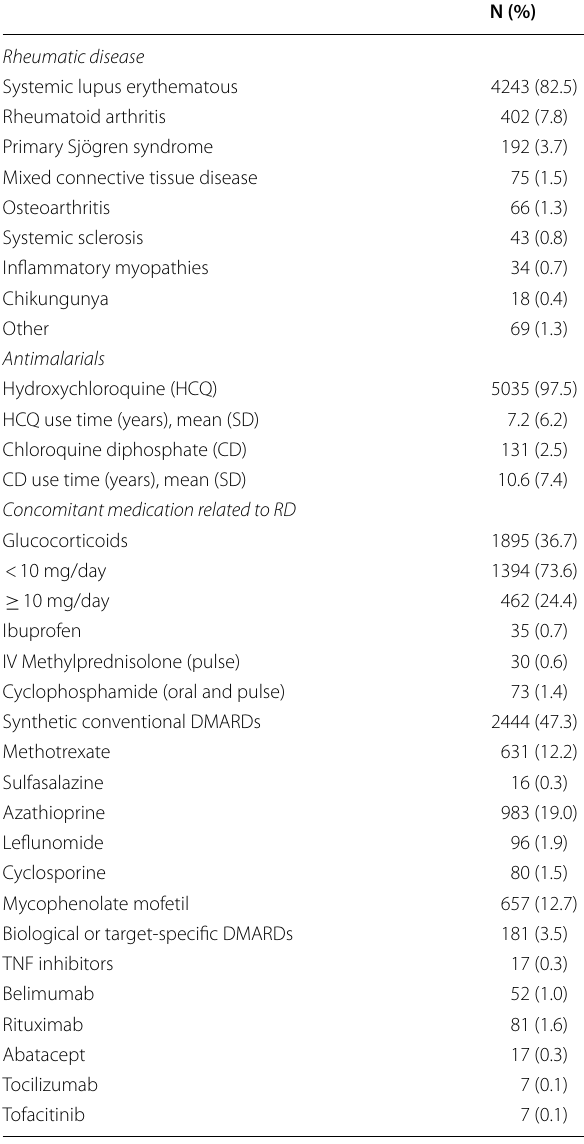
Table 2 Main rheumatic diseases and concomitant medication at